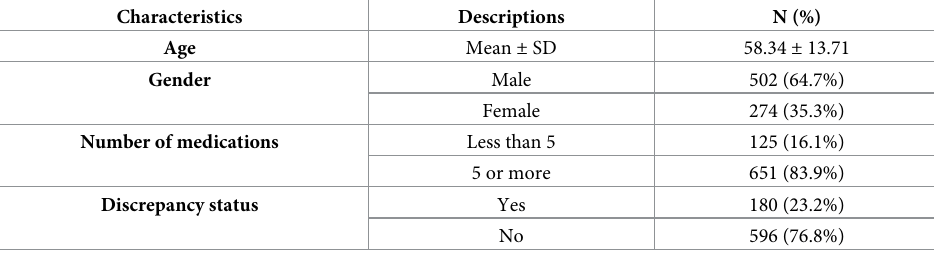
Table 1. Demographic and clinical characteristics of patients (n =